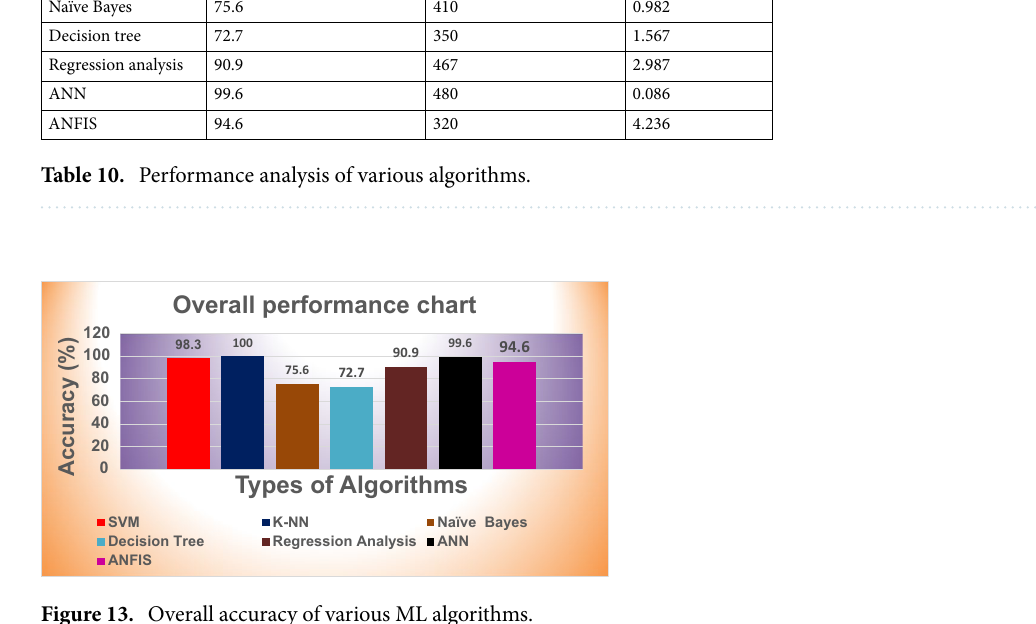
Figure 13. Overall accuracy of various ML